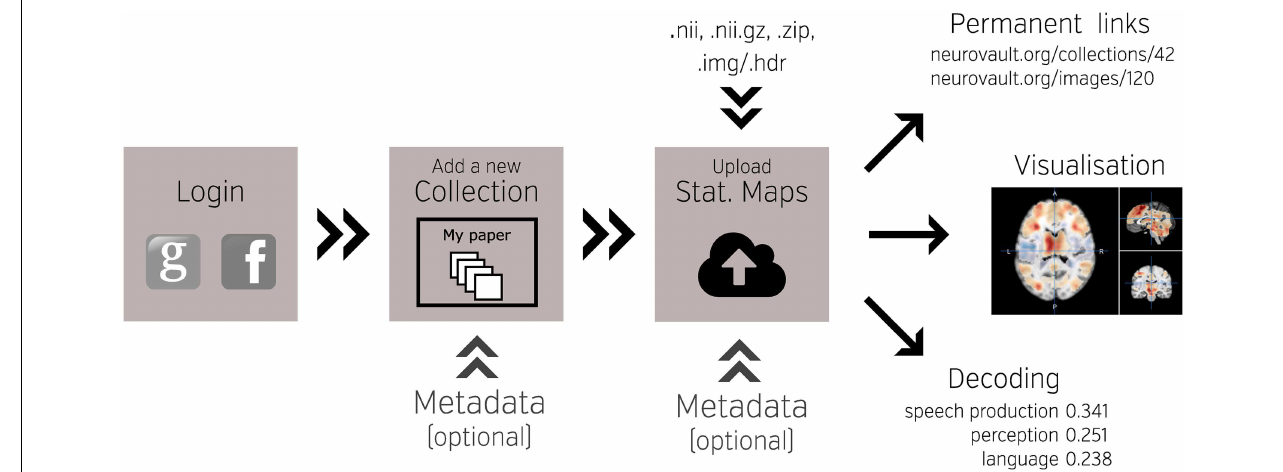
FIGURE 1 | Schematic overview of the NeuroVault platform. To begin working with NeuroVault, users are asked to create an account or log in using their Facebook or Google account. After login, the user creates a collection (representing a paper or a study). At this stage, users can provide a DOI pointing to a paper associated with the collection and/or fill in a number of fields describing the study (see Supplementary Table 1 for details). This additional information is, however, optional. After the